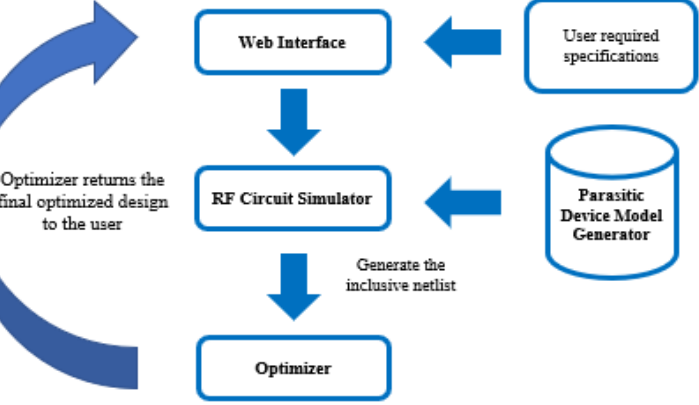
Figure 2. Top-level description of the proposed parasitic-aware design tool for the mm-wave VGAs controlled VGA.